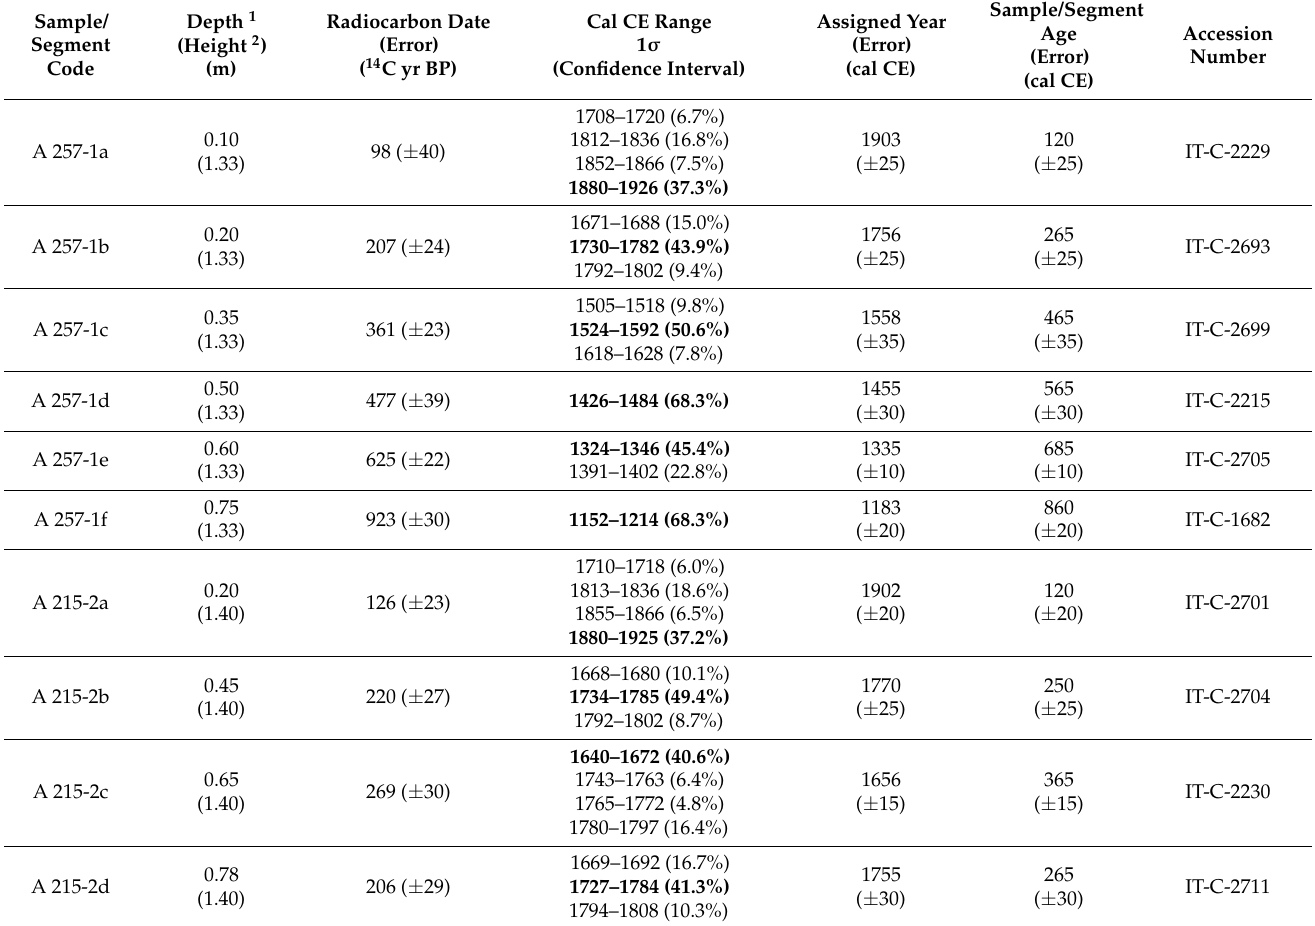
Table 1. Radiocarbon dating results and calibrated ages of sample segments collected from the A 257 and A 215 Grandi- dier